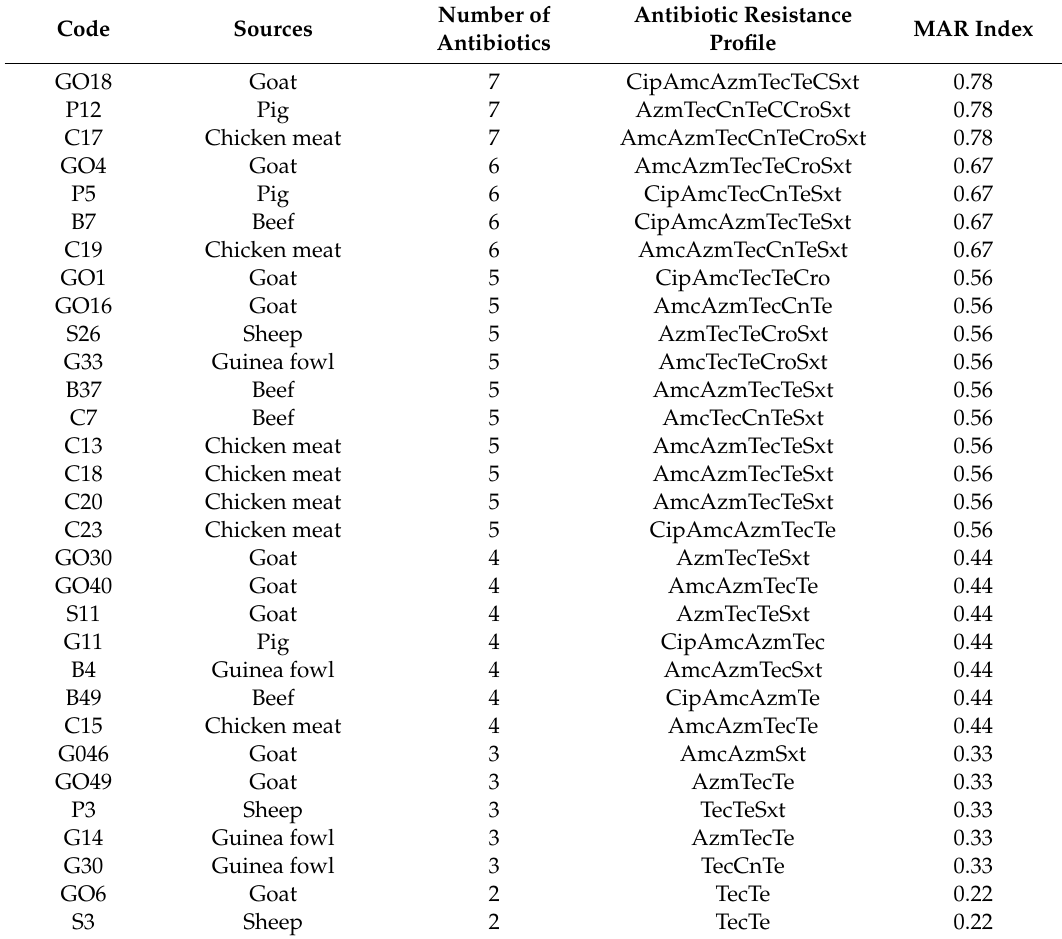
Table 4. Antibiotic resistance profile and multiple antibiotic resistance (MAR) index of E.